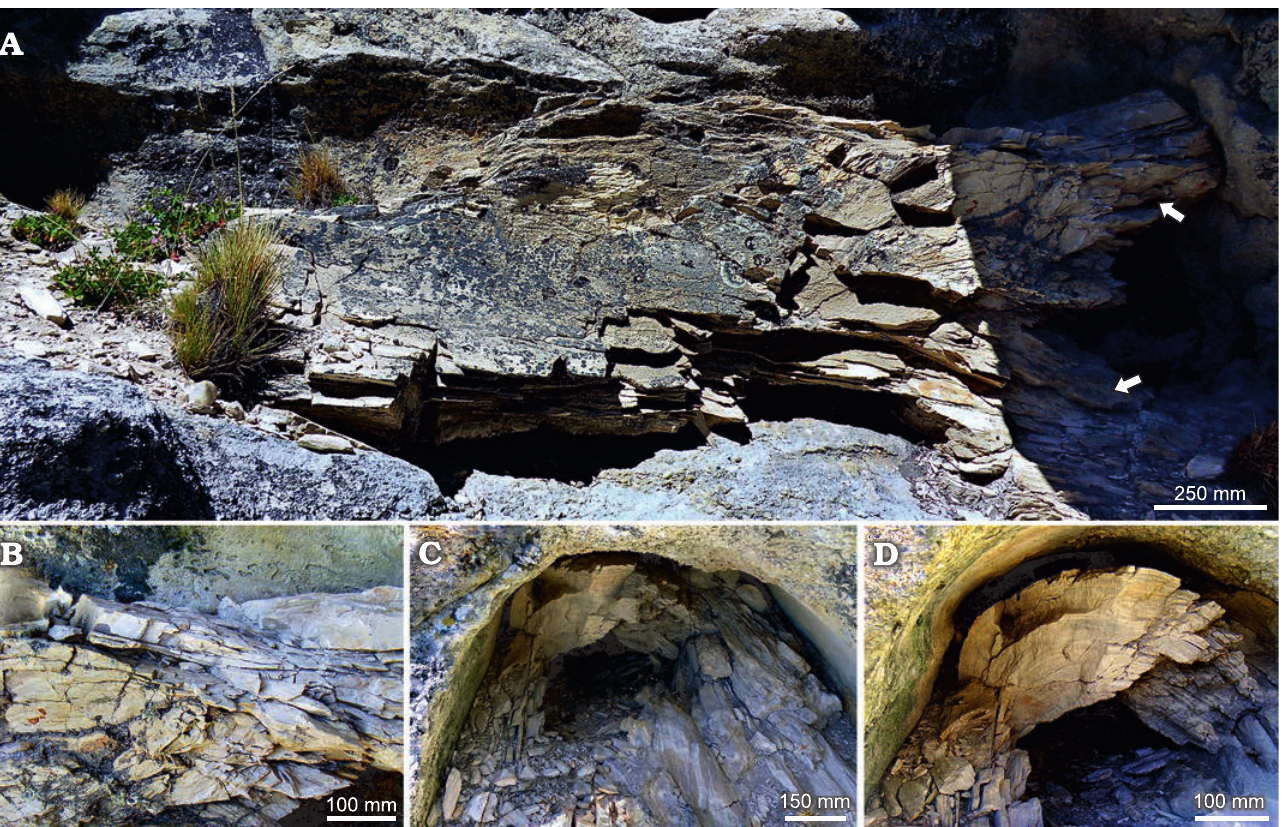
Fig. 5. Araucarian wood Agathoxylon mendezii sp. nov. (MPM­PB­15596), Estancia El Álamo, Santa Cruz Province, Argentina, Berriasian–Valanginian. A , B . Trunk showing diameter and incomplete length. Note branches (arrows). C . Deep intrusion of the trunk into the deposits. D . Detail of the decorti­ cated